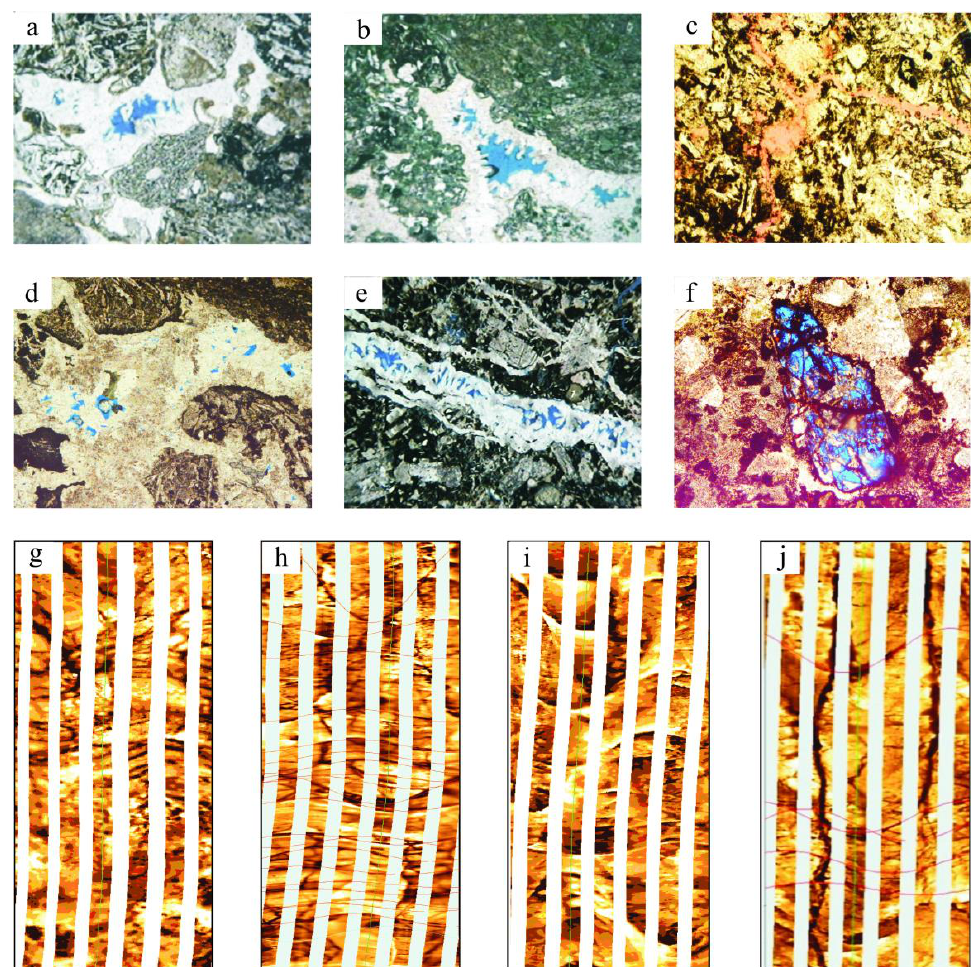
Figure 2. Reservoir space types of the Carboniferous volcanic rock reservoirs in the Chepaizi Uplift. ( a ) Well C031, 1764.0 m, 100×, andesite, intra-granular dissolved pores; ( b ) Well CF3, 1755.7 m, 80×, ( a ) Well C031, 1764.0 m, 100 × , andesite, intra-granular dissolved pores; ( b ) Well CF3, 1755.7 m, 80 × , basalt, inter-crystalline pores; ( c ) Well C47, 2770.9 m, 80×, andesite, 15% matrix dissolved pores, basalt, inter-crystalline pores; ( c ) Well C47, 2770.9 m, 80 × , andesite, 15% matrix dissolved pores, 85% micro fractures; ( d ) Well C542, 2267.6 m, 50×, basalt, 100% matrix dissolved pores; ( e ) Well 85% micro fractures; ( d ) Well C542, 2267.6 m, 50 × , basalt, 100% matrix dissolved pores; ( e )